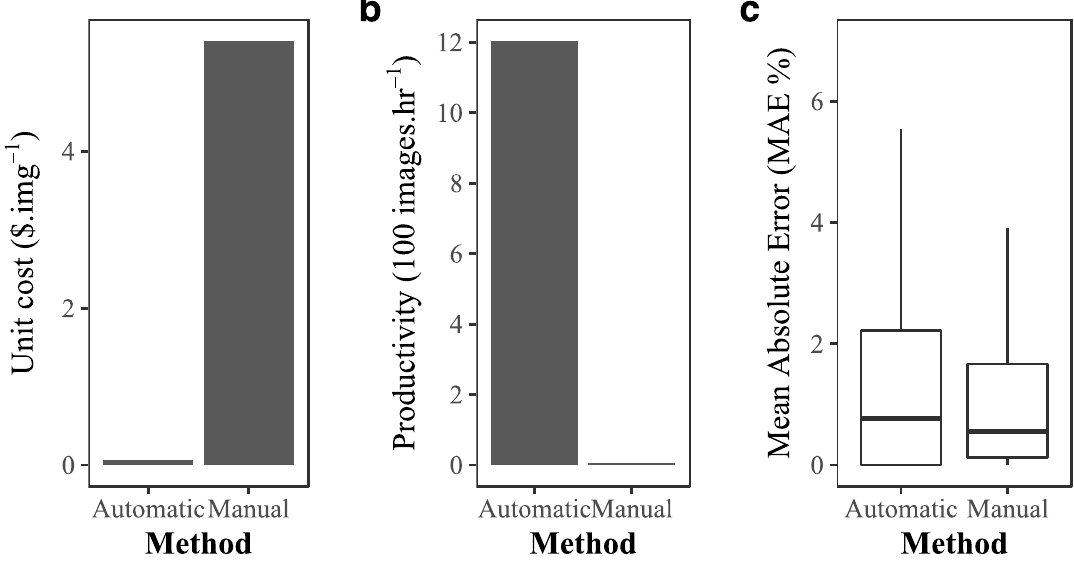
Figure 8. Cost–benefit of implementing automated image analysis in coral reef monitoring: ( a ) individual cost of extracting ecological information from images, ( b ) productivity of generating this information, and ( c ) error of each